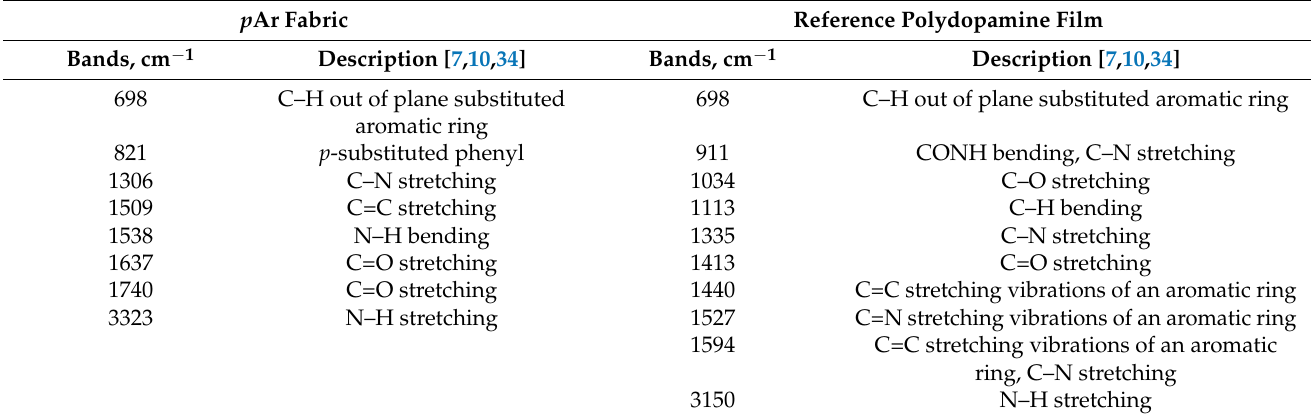
Table 3. FTIR bands assigned for the pAr fabric and the reference polydopamine film.